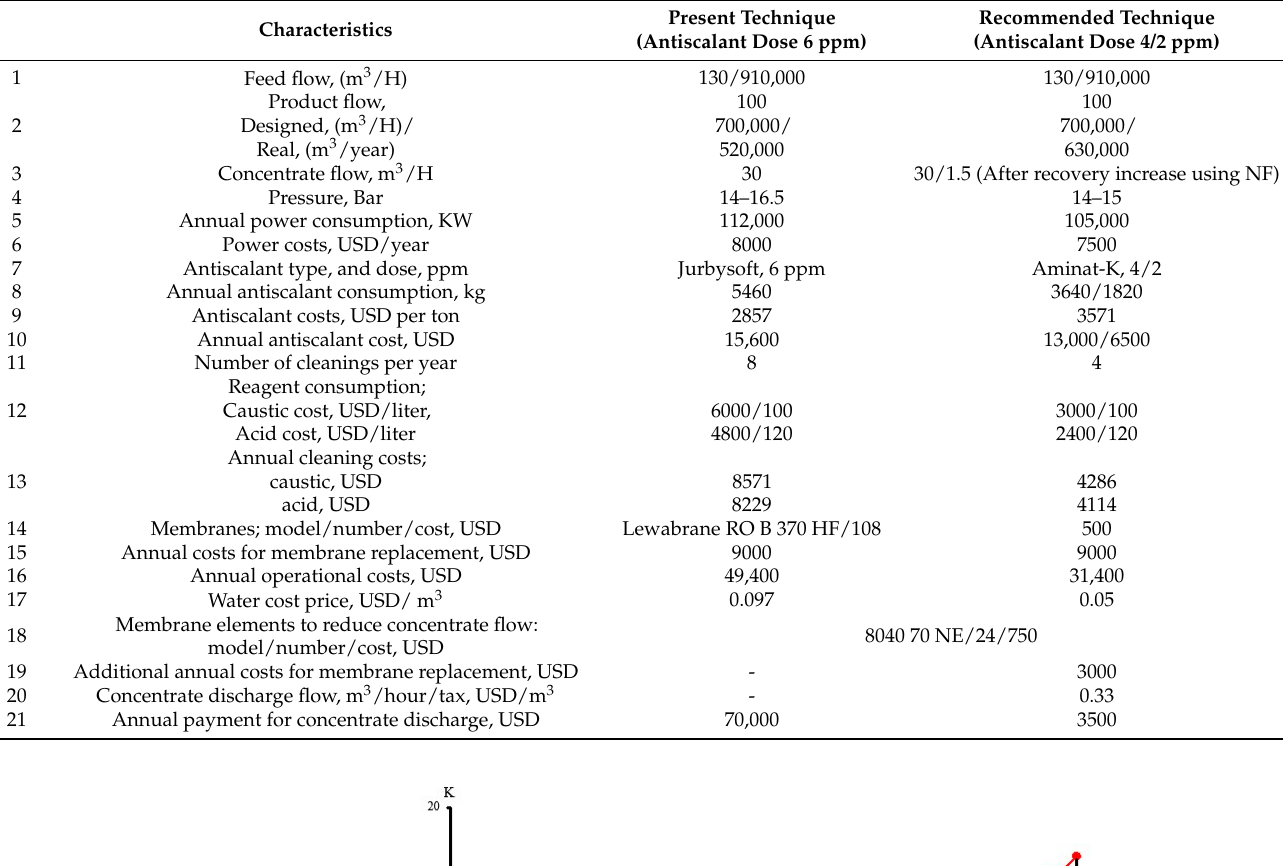
Table 2. Evaluation of operational costs: economical comparison of antiscalant efficiencies and recovery increase due to application of nanofiltration.